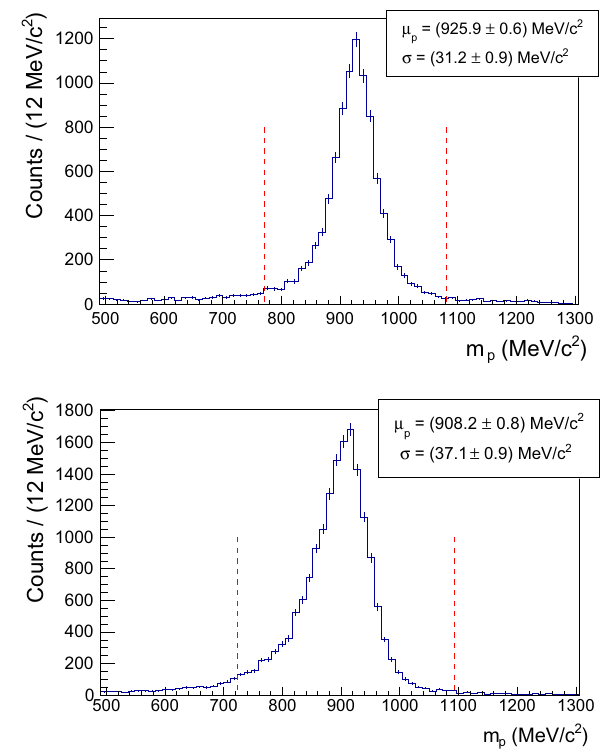
Fig. 2 Mass of the proton from the (cid:2) decay (top) and the primary proton mass (bottom) measured by TOF. The red dashed lines represent the applied